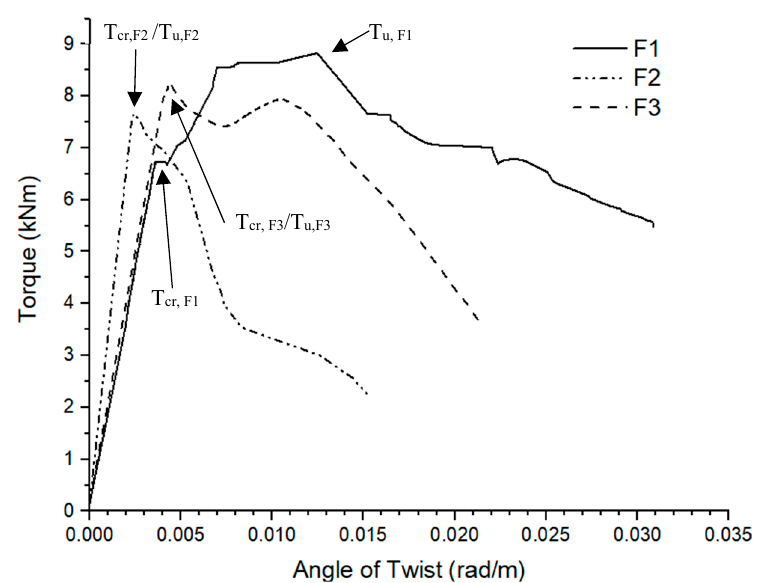
Figure 7. Comparison of the torque vs. angle of twist for beam specimens produced with fibre reinforcement only.